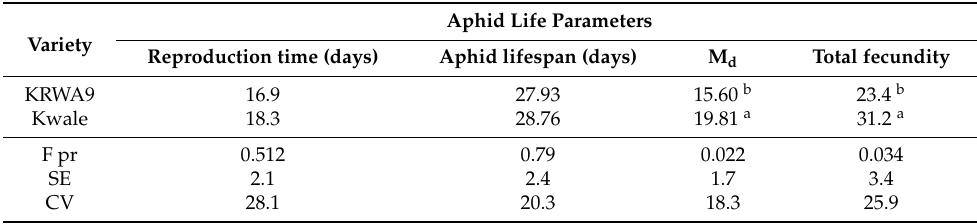
Table 5. The effect of wheat genotype on the reproduction time, total aphid lifespan, effective fecundity (M d ) and total fecundity of RWA.